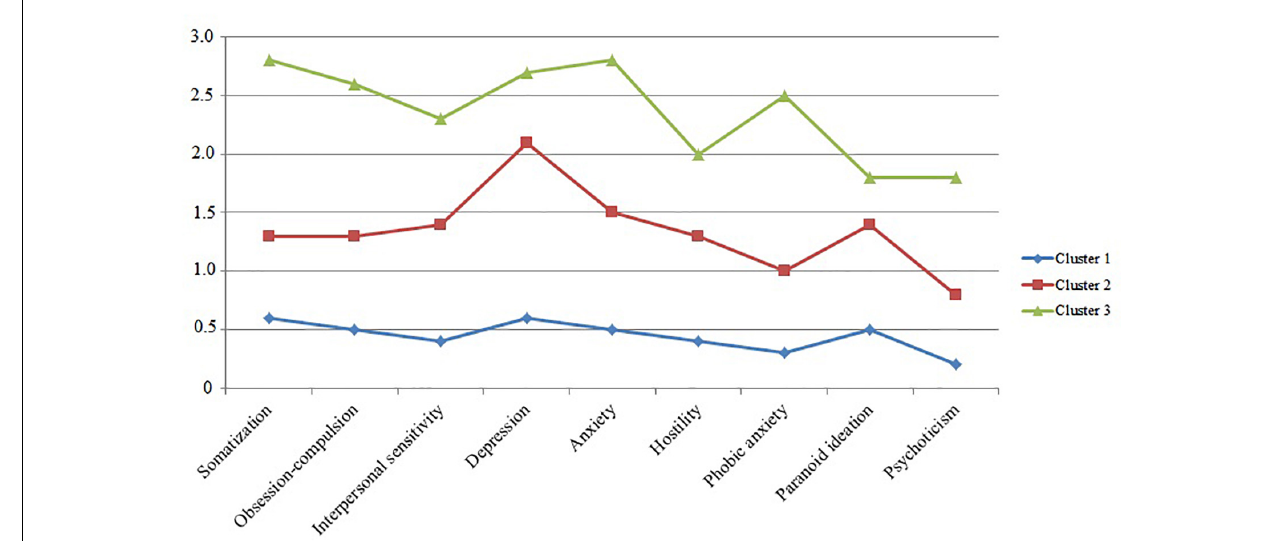
FIGURE 4 | Latent profiles of psychiatric symptom